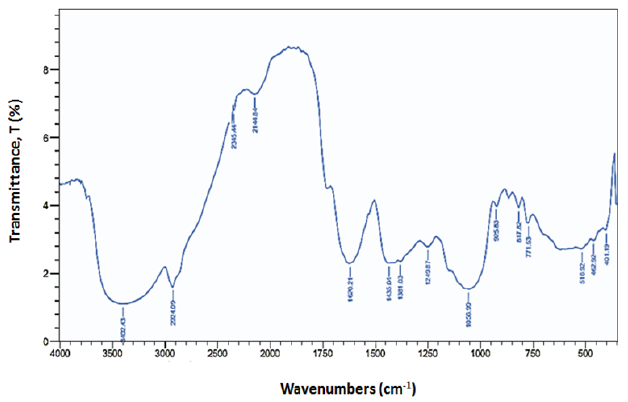
Fig. 6. FT-IR Spectrum from Raja Banana Skin Extract